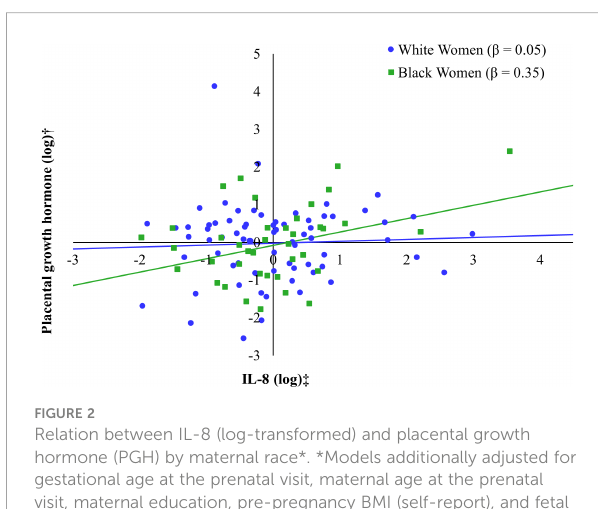
FIGURE 2 Relation between IL-8 (log-transformed) and placental growth hormone (PGH) by maternal race*. *Models additionally adjusted for gestational age at the prenatal visit, maternal age at the prenatal visit, maternal education, pre-pregnancy BMI (self-report), and fetal sex. † Placental growth hormone and IL-8 were log